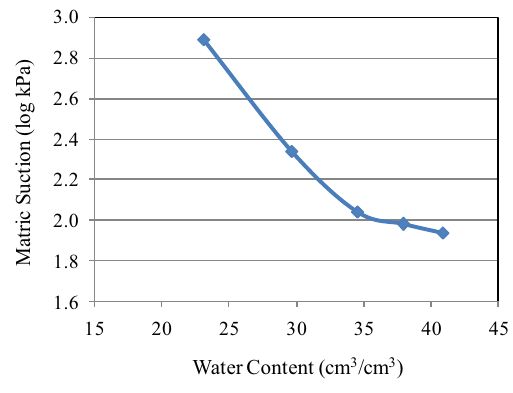
Fig. 2 Moisture content versus matric suction